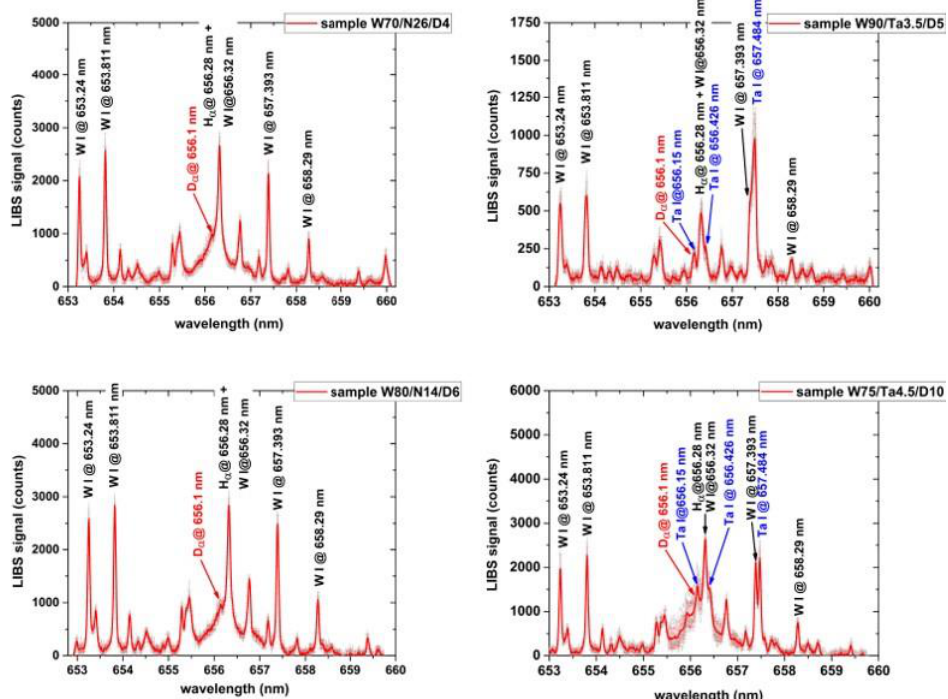
Figure 2. LIBS spectra (in light gray color) of the four samples W70/N26/D4 sample ( up ) and W80/N14/D6 ( bottom ) samples. The red spectrum is the average spectrum of the second to eleventh laser shot. Light red bars represent the SD related to this spectrum. Emission lines of W, Ta, D and H are labeled in different colors (black for W and H, red for D, and blue fot Ta).